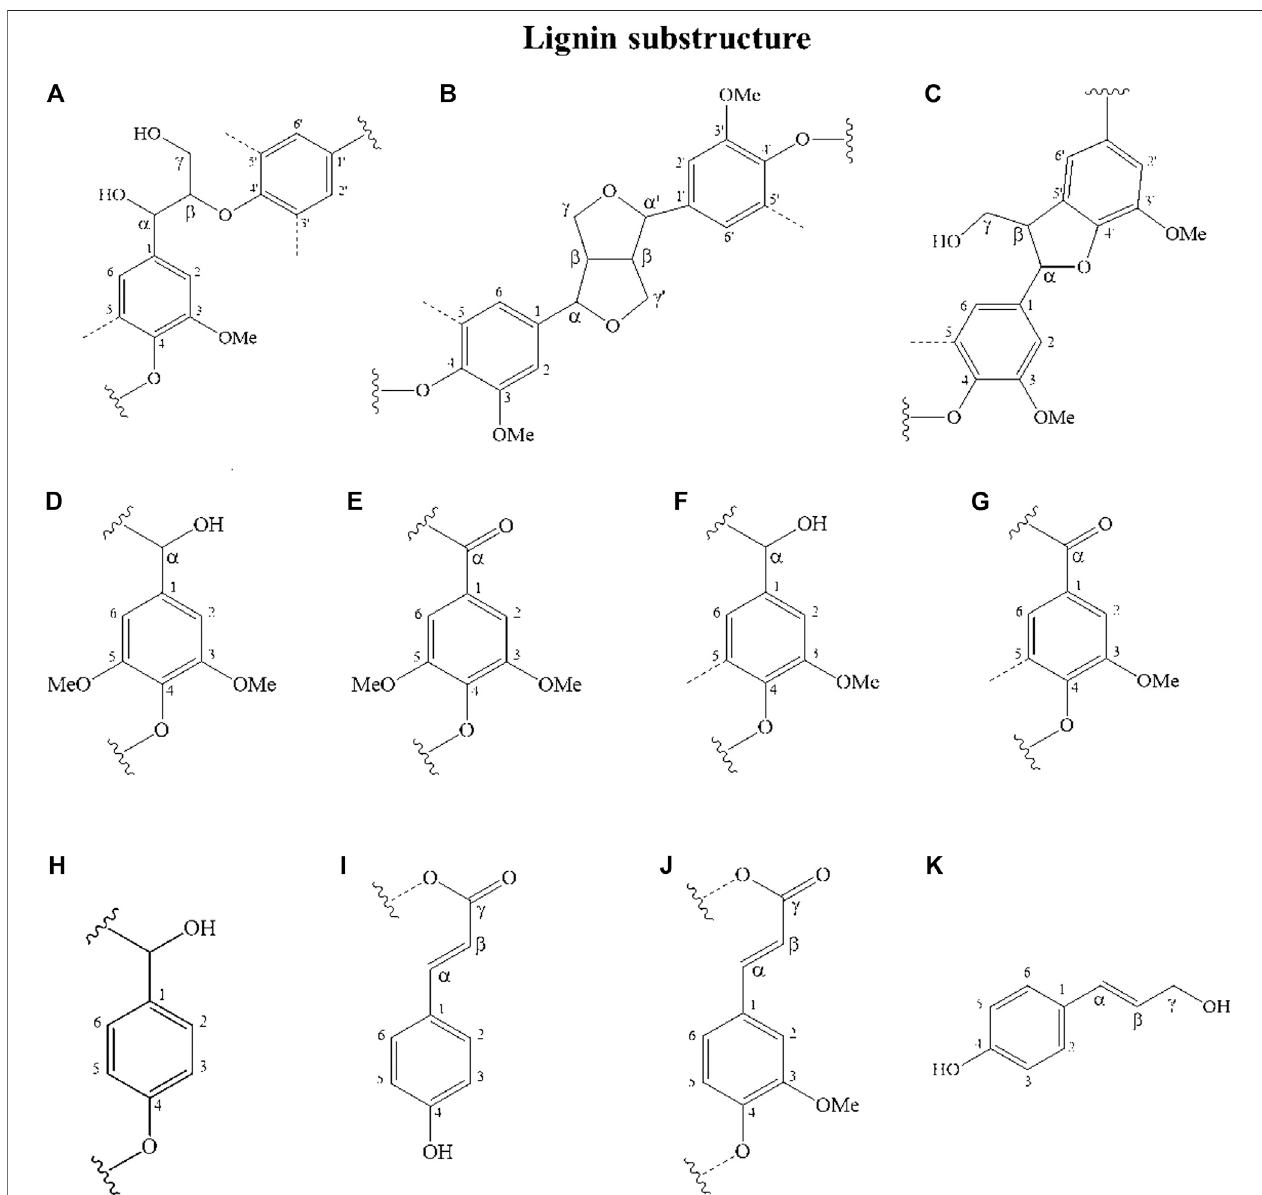
FIGURE 7 | Lignin substructures detected in the HSQC spectra of recovered lignin samples: (A) β -O-4 linkages; (B) resinol structures formed by β - β ; (C) phenylcoumaransubstructuresformedby β -5; (D) syringylunit; (E) oxidizedsyringylunitbearingacarbonylgroupatC α (phenolic); (F) guaiacylunit; (G) oxidizedguaiacyl unit bearing a carbonyl group at C α (phenolic); (H) p-hydroxyphenyl unit; (I) p-coumarate; (J) ferrulate; and (K) p-hydroxycinnamyl alcohol.